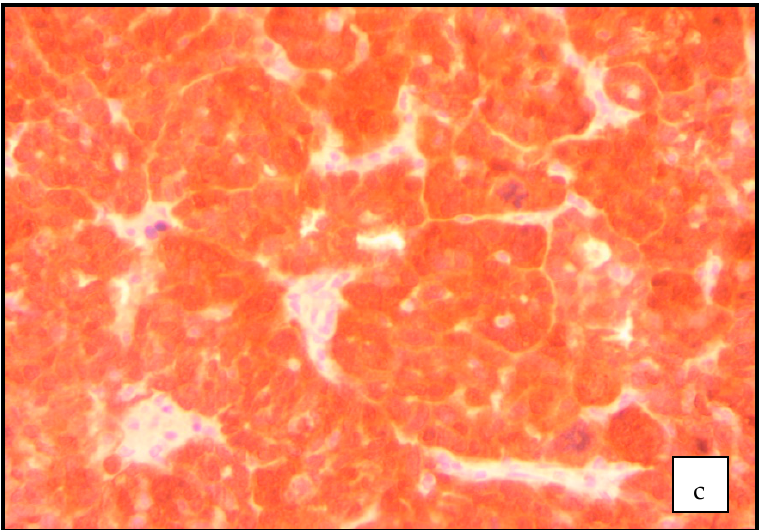
Figure 3. ( a – c ) Pathological examination of the surgical preparation (our case): ( a ) primary malignant